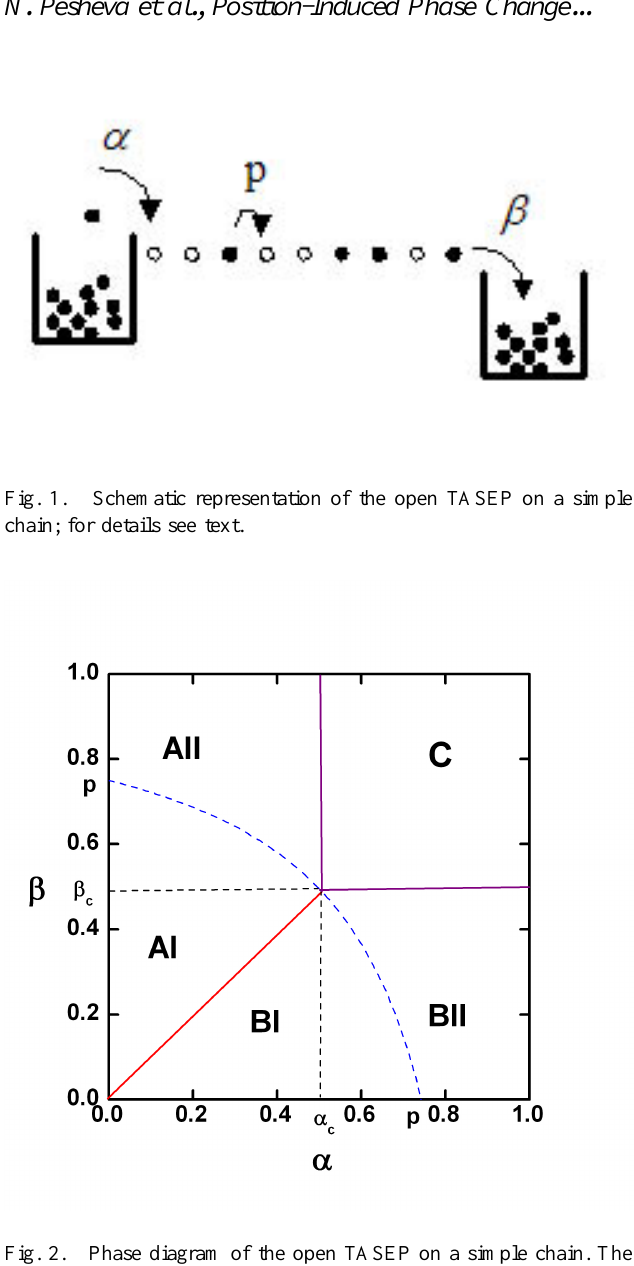
Fig. 2. Phase diagram of the open TASEP on a simple chain. The regions of the different phases are explained in the text.